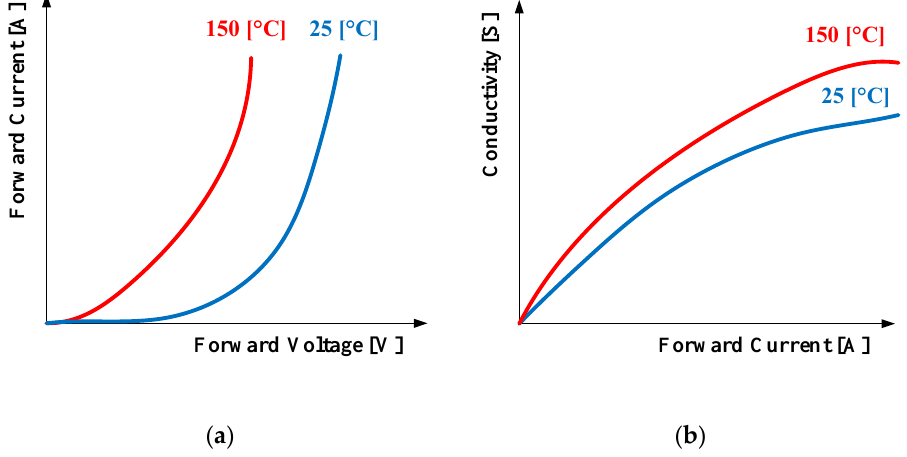
Figure 2. ( a ) VA characteristic; ( b ) conductivity characteristics.